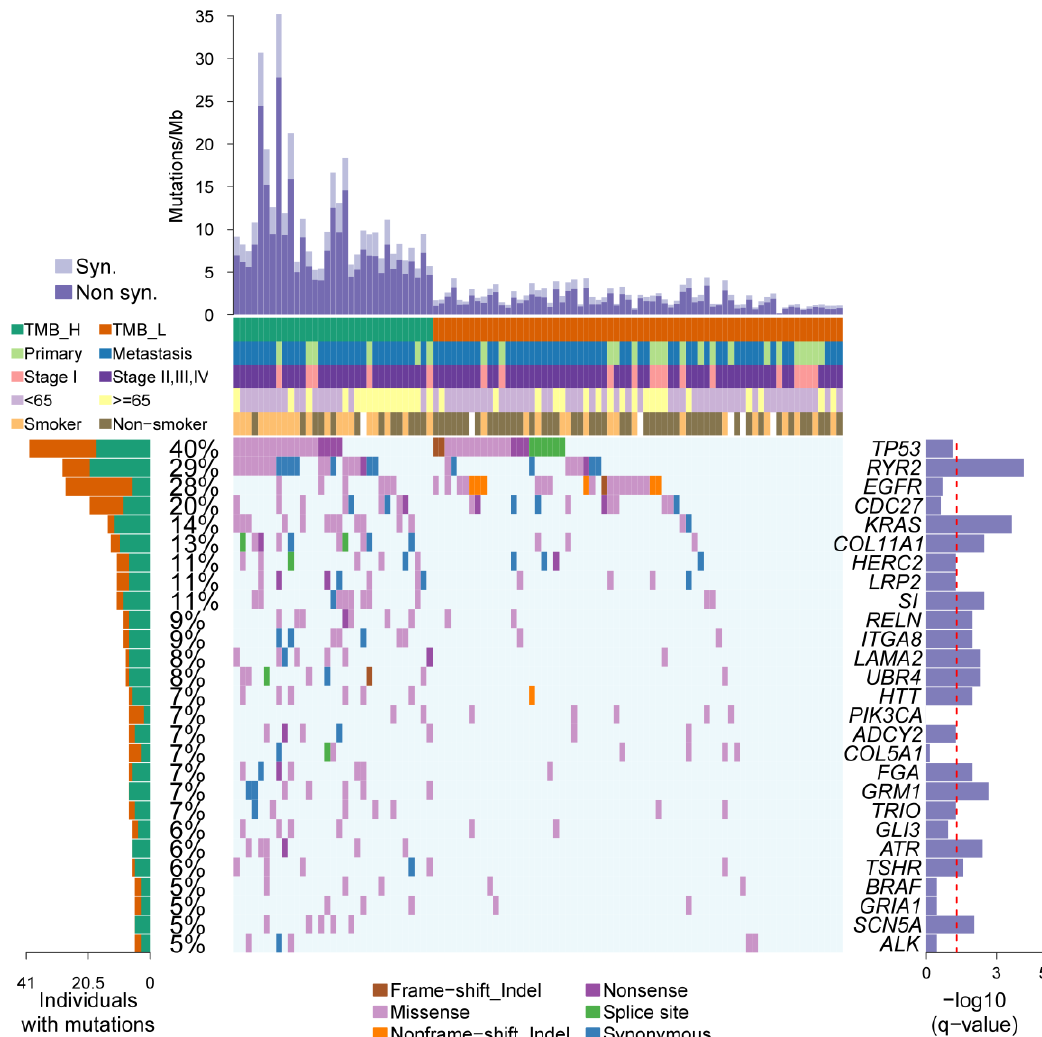
Figure 2. Mutational landscape and the clinical information of 101 patients. The upper side of Figure 2 shows the details of tumor mutation burden (TMB) and the clinical information of each patients. The middle panel of Figure 2 shows the genetic alterations, such as frameshift indel, non-frameshift indel, nonsense mutation, missense mutation, splice site mutation, and synonymous mutation. The left barplot shows the mutational frequency of each gene. The right barplot emphasizes the significant degree of mutation status of each gene, and the p -values were adjusted by the Benjamini and Hochberg method (BH). TMB-H, High tumor mutation burden; TMB-L, Low tumor mutation burden